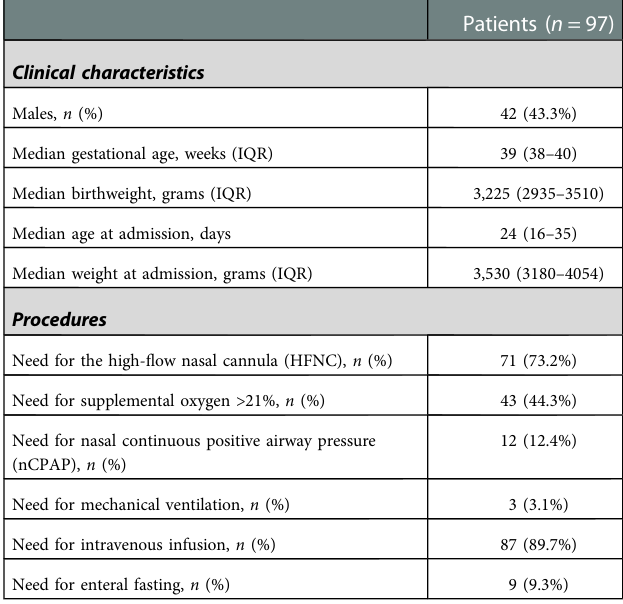
TABLE 2 Clinical characteristics and procedures of included patients with acute bronchiolitis.